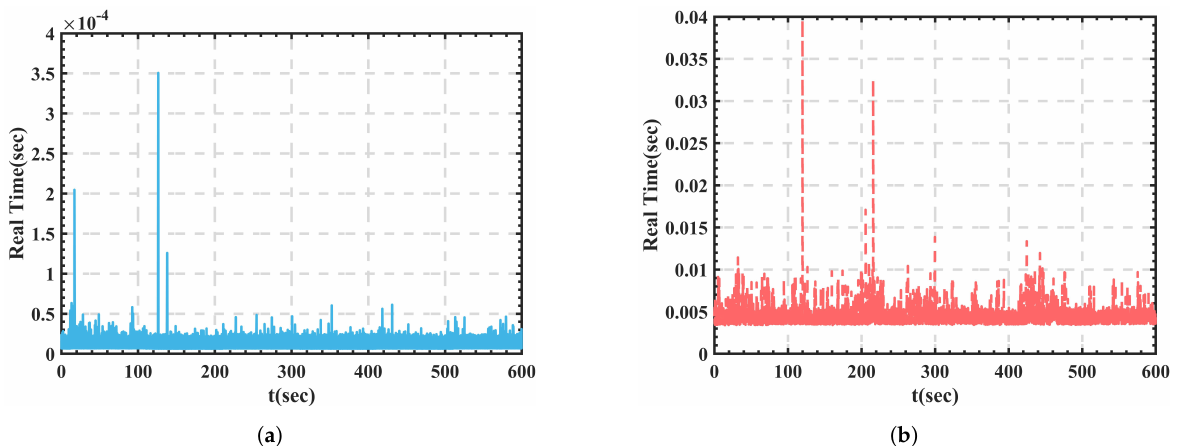
Figure 18. When n y = 3, at each sampling time: ( a ) mpQP-eMPC calculation time; ( b ) tMPC calculation time.